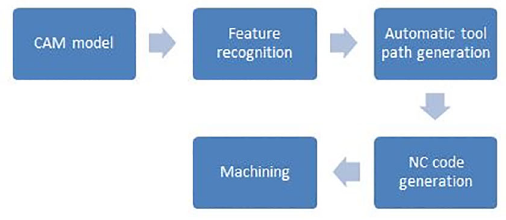
Fig. 2. Modern path from model to